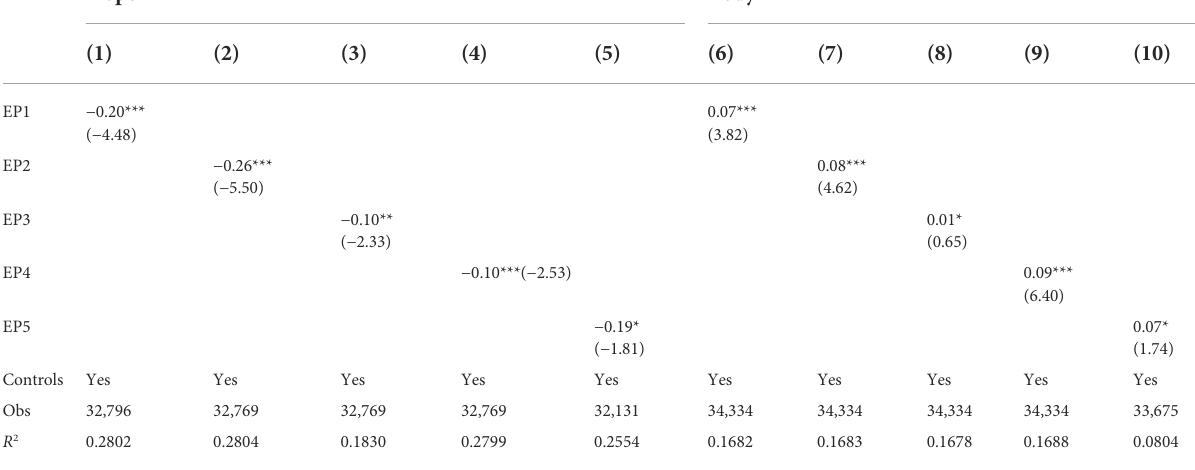
TABLE 6 Robustness test: replace the main explanatory variable OLS.